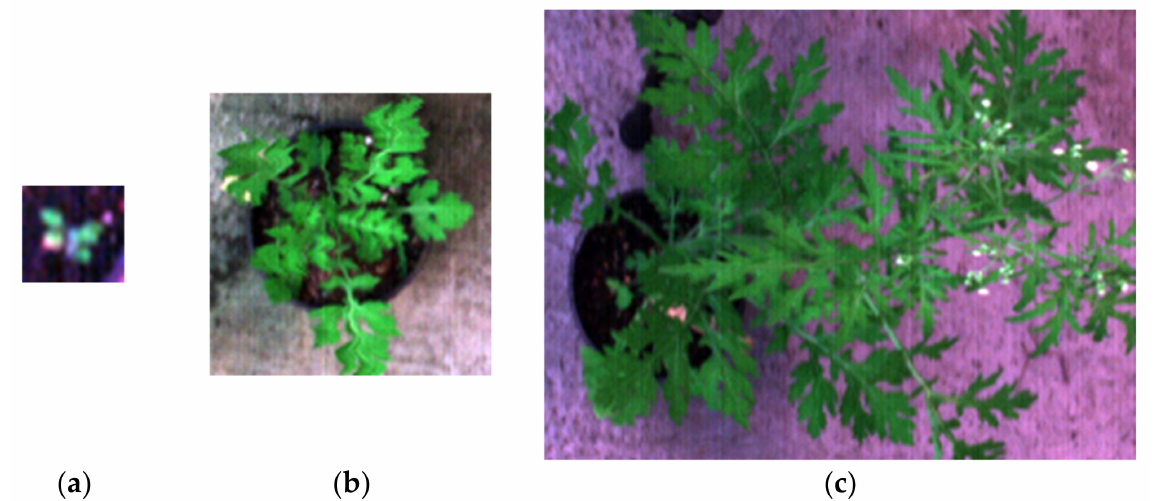
Figure 6. Filtered regions of interest (ROI) of the three parthenium growth stages: ( a ) seedling, ( b ) rosette, and ( c ) flowering adult.